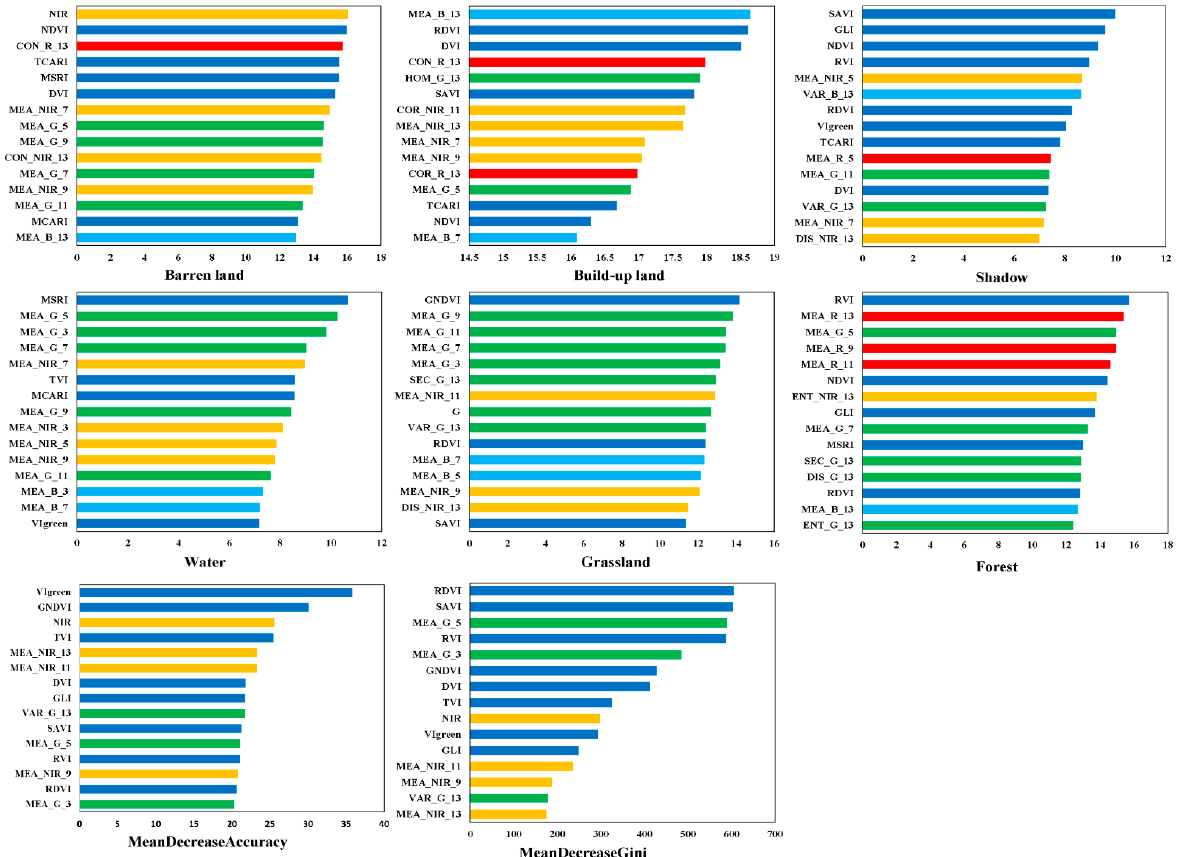
Figure 5. Variable importance scores of top 15 features. Variable names are given as (feature name)-(base spectral band)- (window size). For example, MEA_NIR_13 indicates an MEA based on an NIR band with a window size of 13 × 13. Bar color indicates the spectral bands, where green band is in green, red band in red, blue band in blue, NIR band in orange, and vegetation index variables in dark blue.